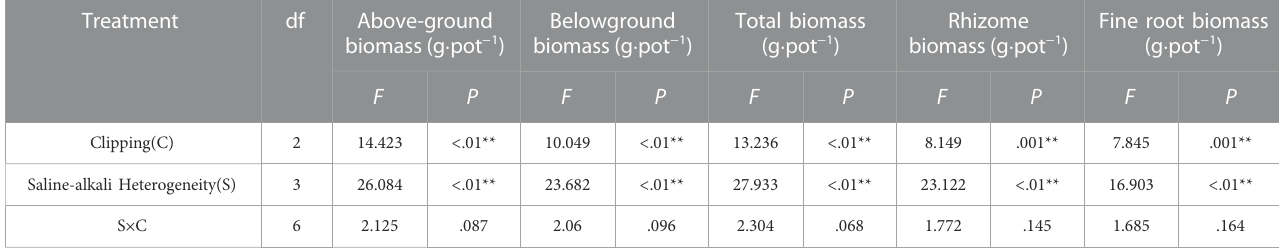
TABLE 1 Statistical summary of two-way ANOVA evaluating the effects of saline-alkali heterogeneity of soil and clipping their combined effects on the above-ground biomass(AGB),belowground biomass (BGB), total biomass (TB), rhizome biomass (RB), fi ne root biomass (FRB) of L.chinensis . Values are F ratios and their signi fi cance for effects. F values and signi fi cance levels (**, p < .01; *, p < .05) are given. Treatment df